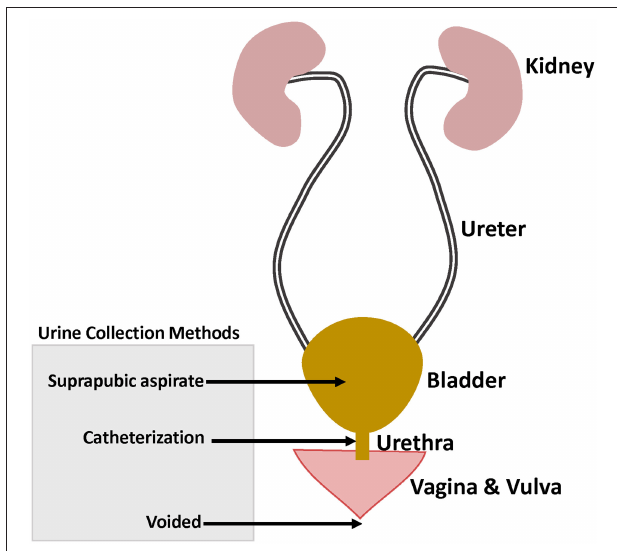
FIGURE 1 | Female genitourinary tract system highlighting the different urine collection methods used in urinary microbiome